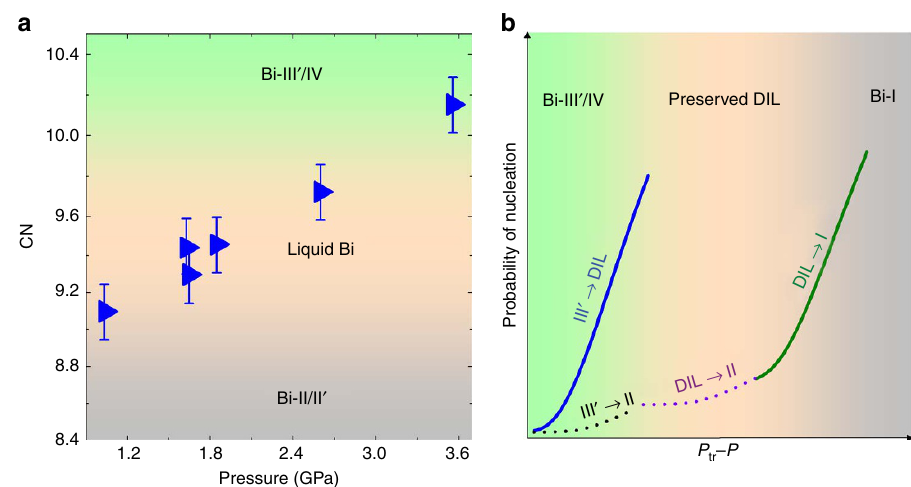
Figure 4 | Coordination number of Bi in metastable liquid and probability of nucleation. ( a ) Change of the nearest-neighbour coordination number (CN) of liquid Bi with pressure. The CN (blue solid right triangle) is calculated using the pair distribution function of liquid, assuming that the density of liquid is equal to that of Bi-II at corresponding pressure–temperature conditions. The uncertainties of CN are estimated from the errors in fitting the first sharp peak in the pair distribution functions of the liquid. The CN is close to that of Bi-II at low pressures, while the CN increases with pressure and approaches to that of Bi-IV at high pressures. ( b ) Nucleation probability in the phase transitions as a function of P tr (cid:2) P under decompression, where P tr is thermodynamic equilibrium pressure of Bi-III 0 (or IV) and II. The probability is proportional to exp[ (cid:2) D G */ k B T ], where D G * is the free energy barrier in the formation of nucleation, and is proportional to g 3 / ( D G V ) 2 ; g and D G V are the interfacial energy and difference of Gibbs free energy between parent and new phases, which are closely correlated to structures. In the first step, Bi-III 0 to DIL transition has large probability in formation of liquid (blue solid line) compared with that of Bi-II in Bi-III to Bi-II transition (black dash line), owing to much smaller interfacial energy in solid/liquid interfaces. In the second step, the large kinetic energy barrier in crystallization of the transient liquid suppresses the formation of Bi-II (purple dash line), eventually resulting in the preservation of the DIL. Upon further decompression, probability of nucleation of Bi-I (olive solid line) increases due to the increase in difference of Gibbs free energies between DIL and